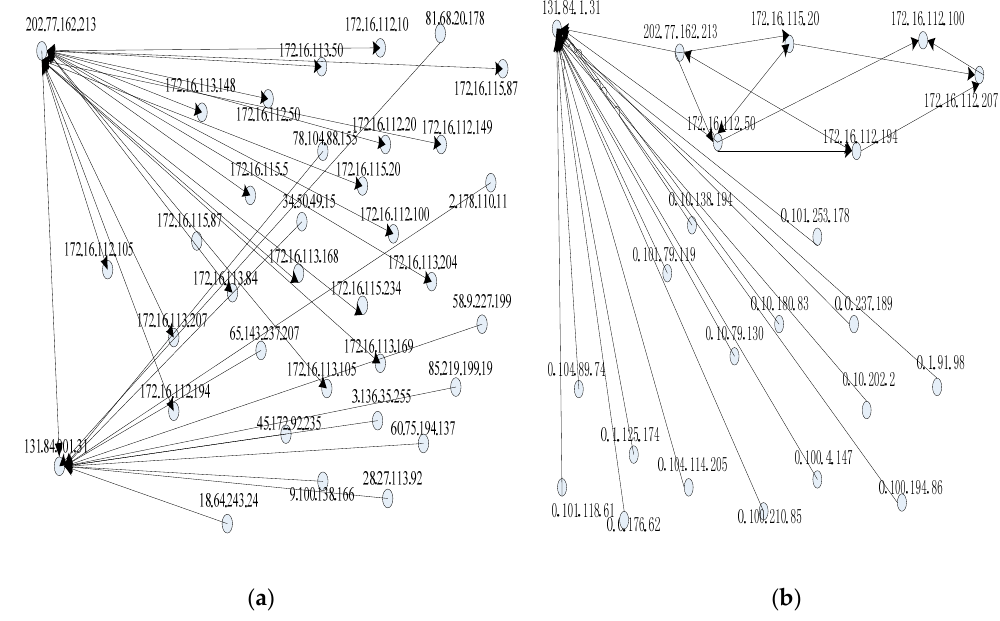
Figure 6. The Original Evidence Graph. ( a ) LLDOS 1.0; ( b ) LLDOS 2.0.2.